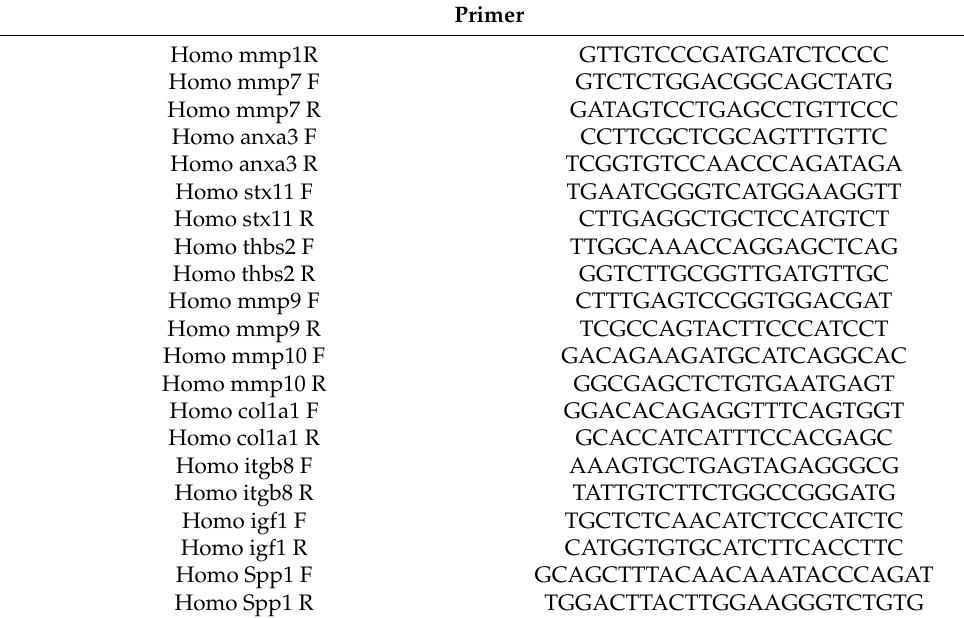
Table 2. Primers used for PCR analysis.